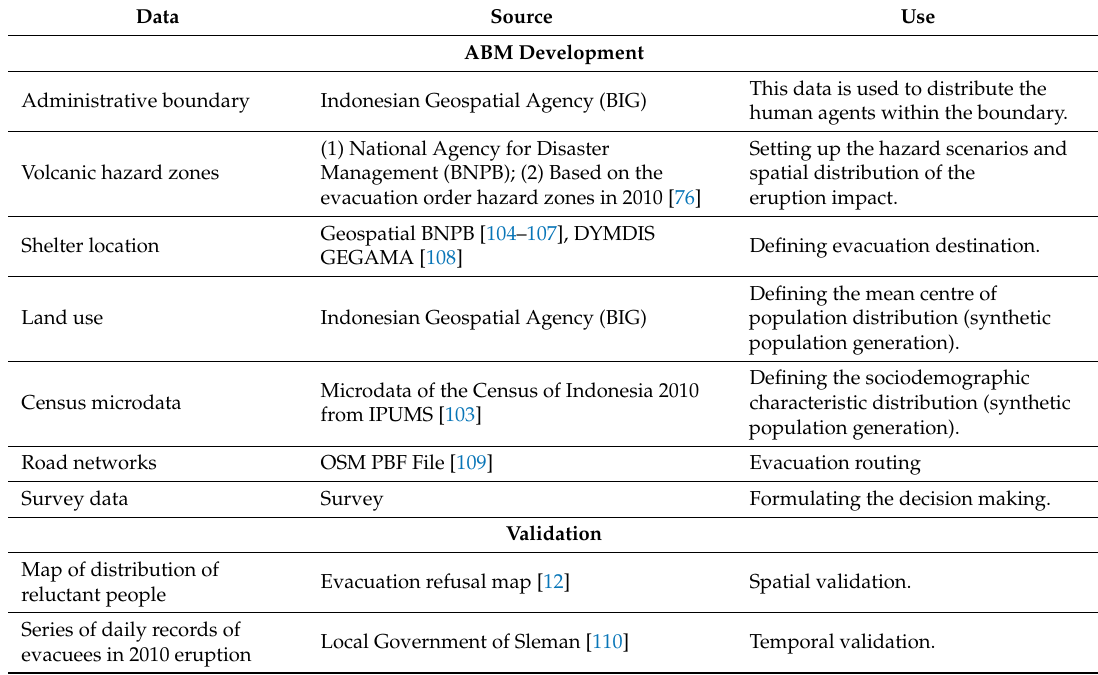
Table 1. Dataset list for the